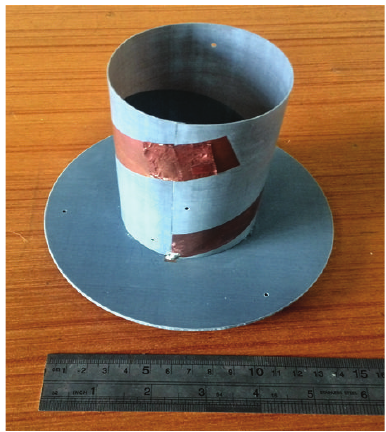
Figure 6: View of the prototype of the proposed strip-helical